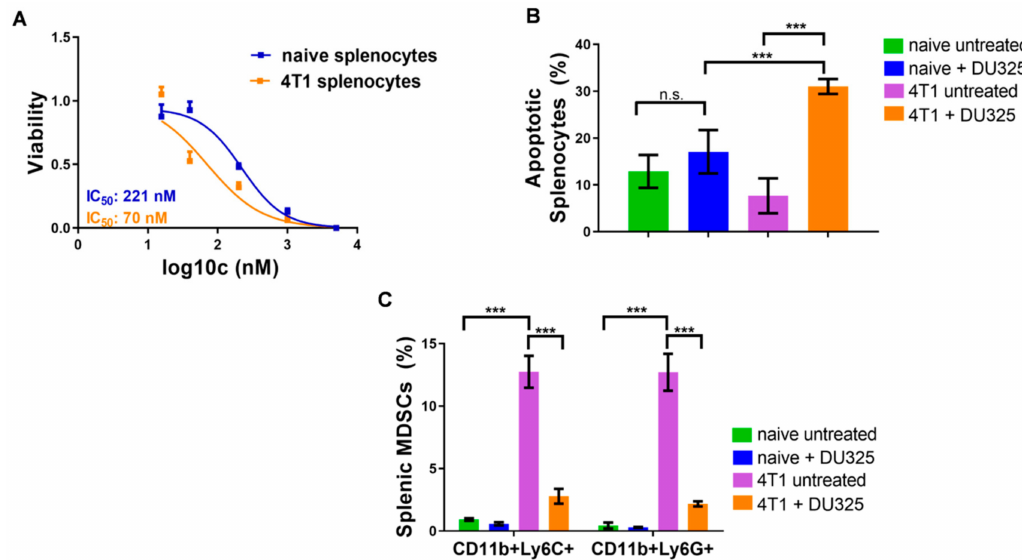
Figure 9. DU325 treatment hampered the viability of splenocytes, both CD11b +/ Ly6C + and CD11b +/ Ly6G + splenic MDSCs. Cells were treated with 5 µ M, 1 µ M, 200 nM, 40 nM, and 20 nM DU325 for 72 h and assayed by the resazurin viability test ( A ). The percentage of AnnV +/ PI + late apoptotic cells was increased after treatment with 200 nM DU325 for 72 h ( B ). The immunofluorescent staining showed a reduction of both monocytic CD11b +/ Ly6C + and granulocytic CD11b + Ly6G + MDSCs treated with 200 nM DU325 for 72 h ex vivo ( C ). Data are shown as arithmetic mean values ± standard deviation from triplicate experiments. Statistical significance was set to *** p <